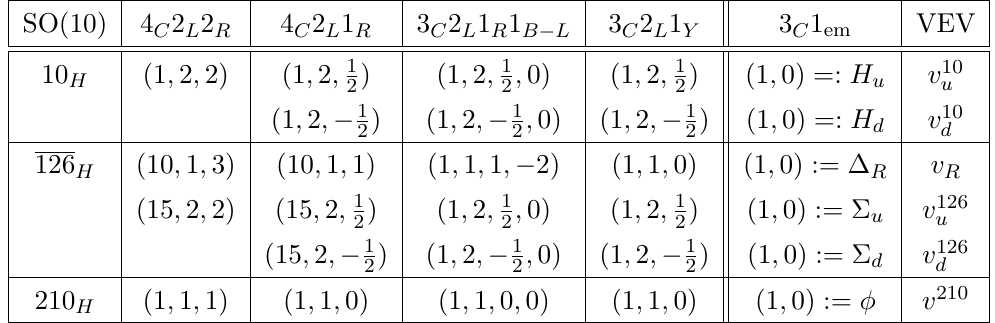
Table 2 . Decomposition of the scalar multiplets according to the various subgroups in our breaking chains. We only display the multiplets which get nonzero vacuum expectation values (VEVs) in the di(cid:11)erent models considered in the